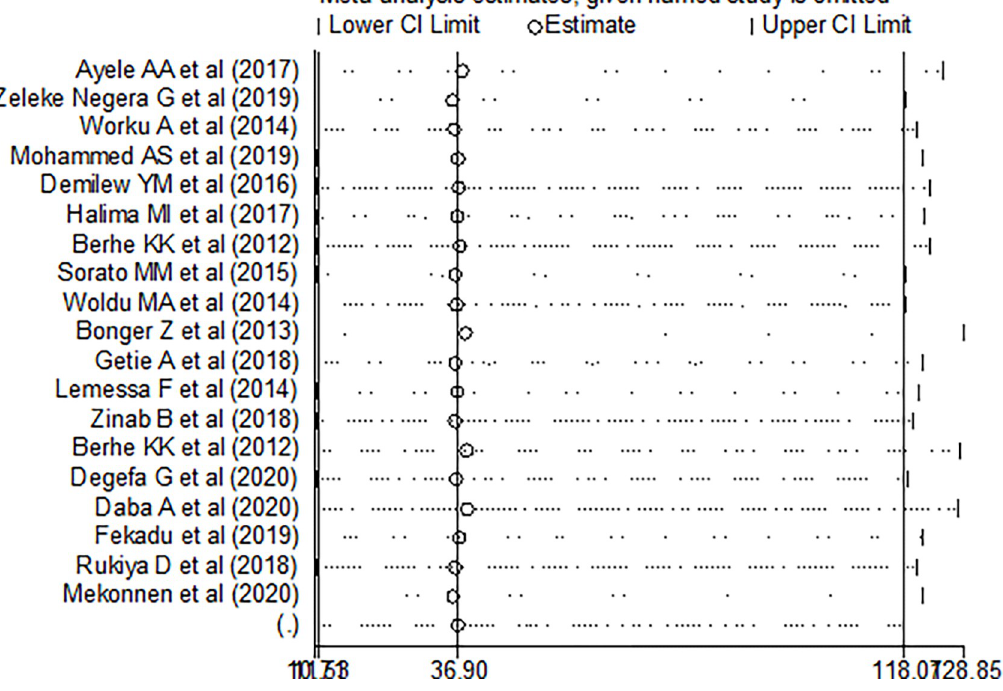
Fig 4. One-leave-out sensitivity analysis for studies conducted on proportion of dietary adherence among people with type 2 DM in Ethiopia, 2012–2020.